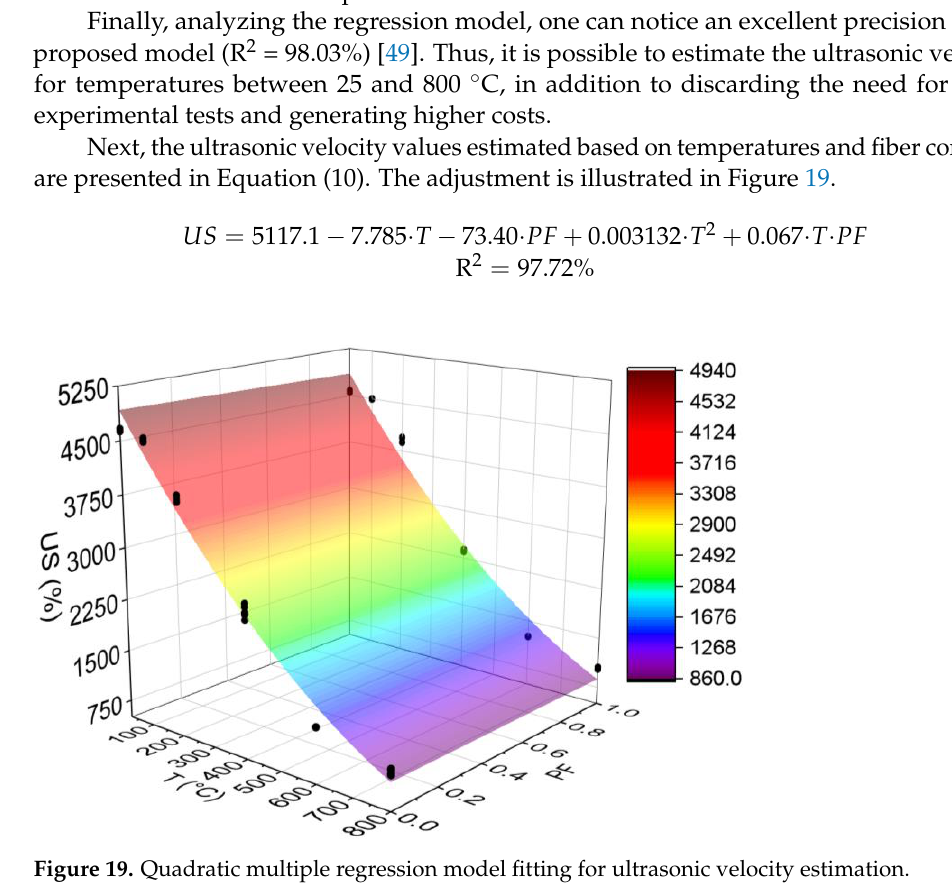
Figure 19. Quadratic multiple regression model fitting for ultrasonic velocity estimation.